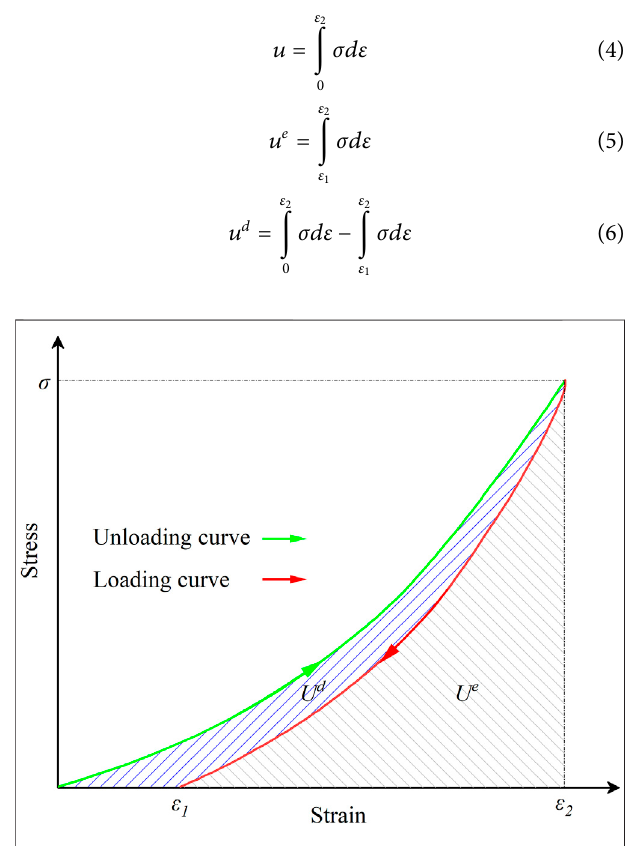
FIGURE9 | Distribution diagram ofelastic energy and dissipated energy of loaded